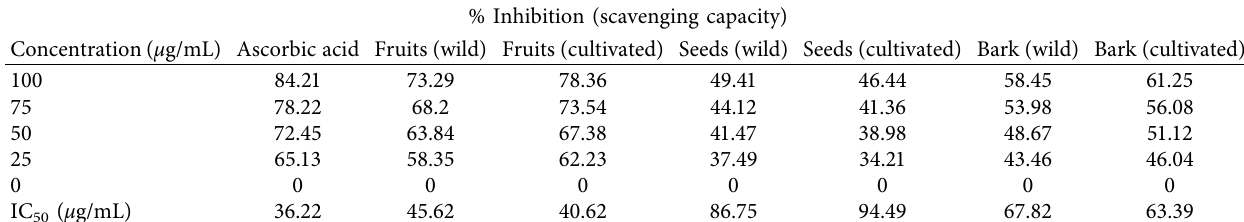
Table 3: Mean absorbance and IC 50 values of extract and ascorbic acid at different concentrations.